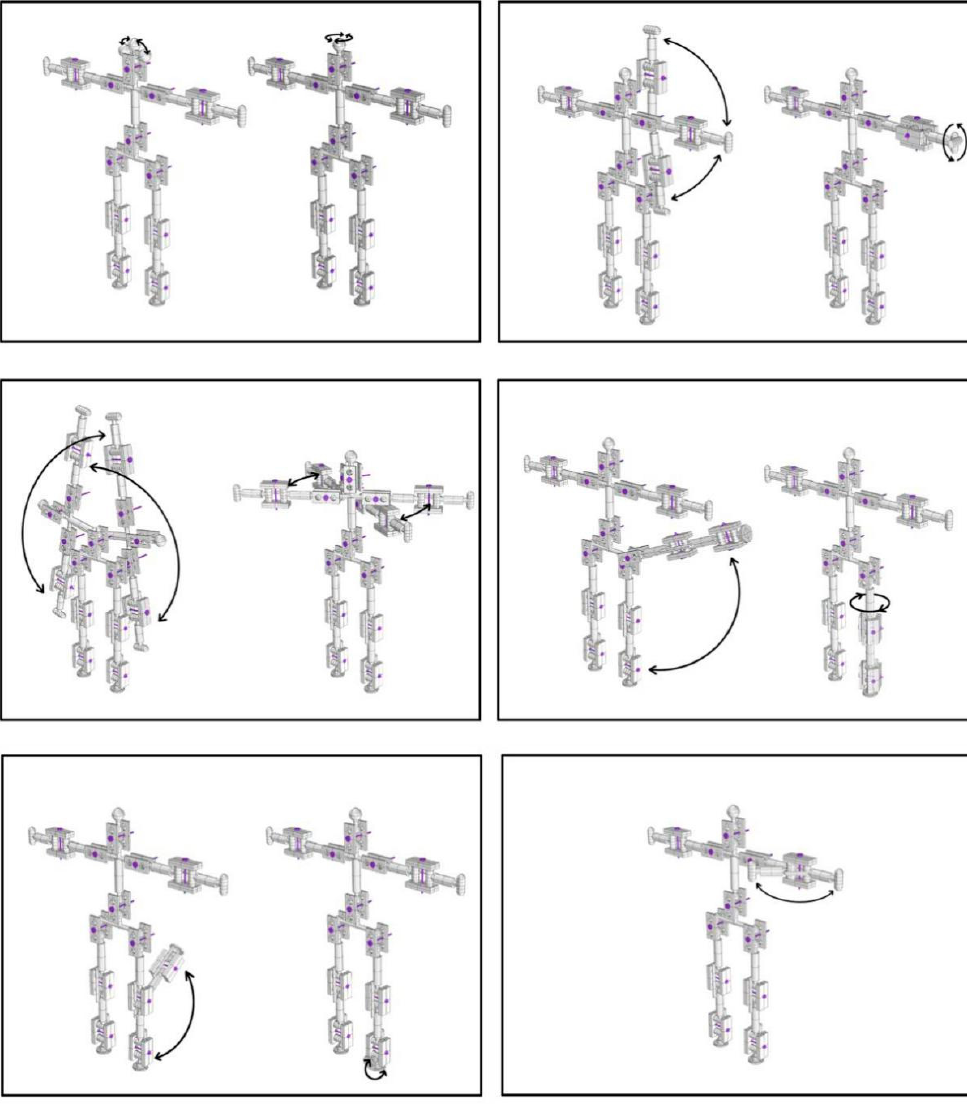
Figure 2. The moving mode and range of each joint in the